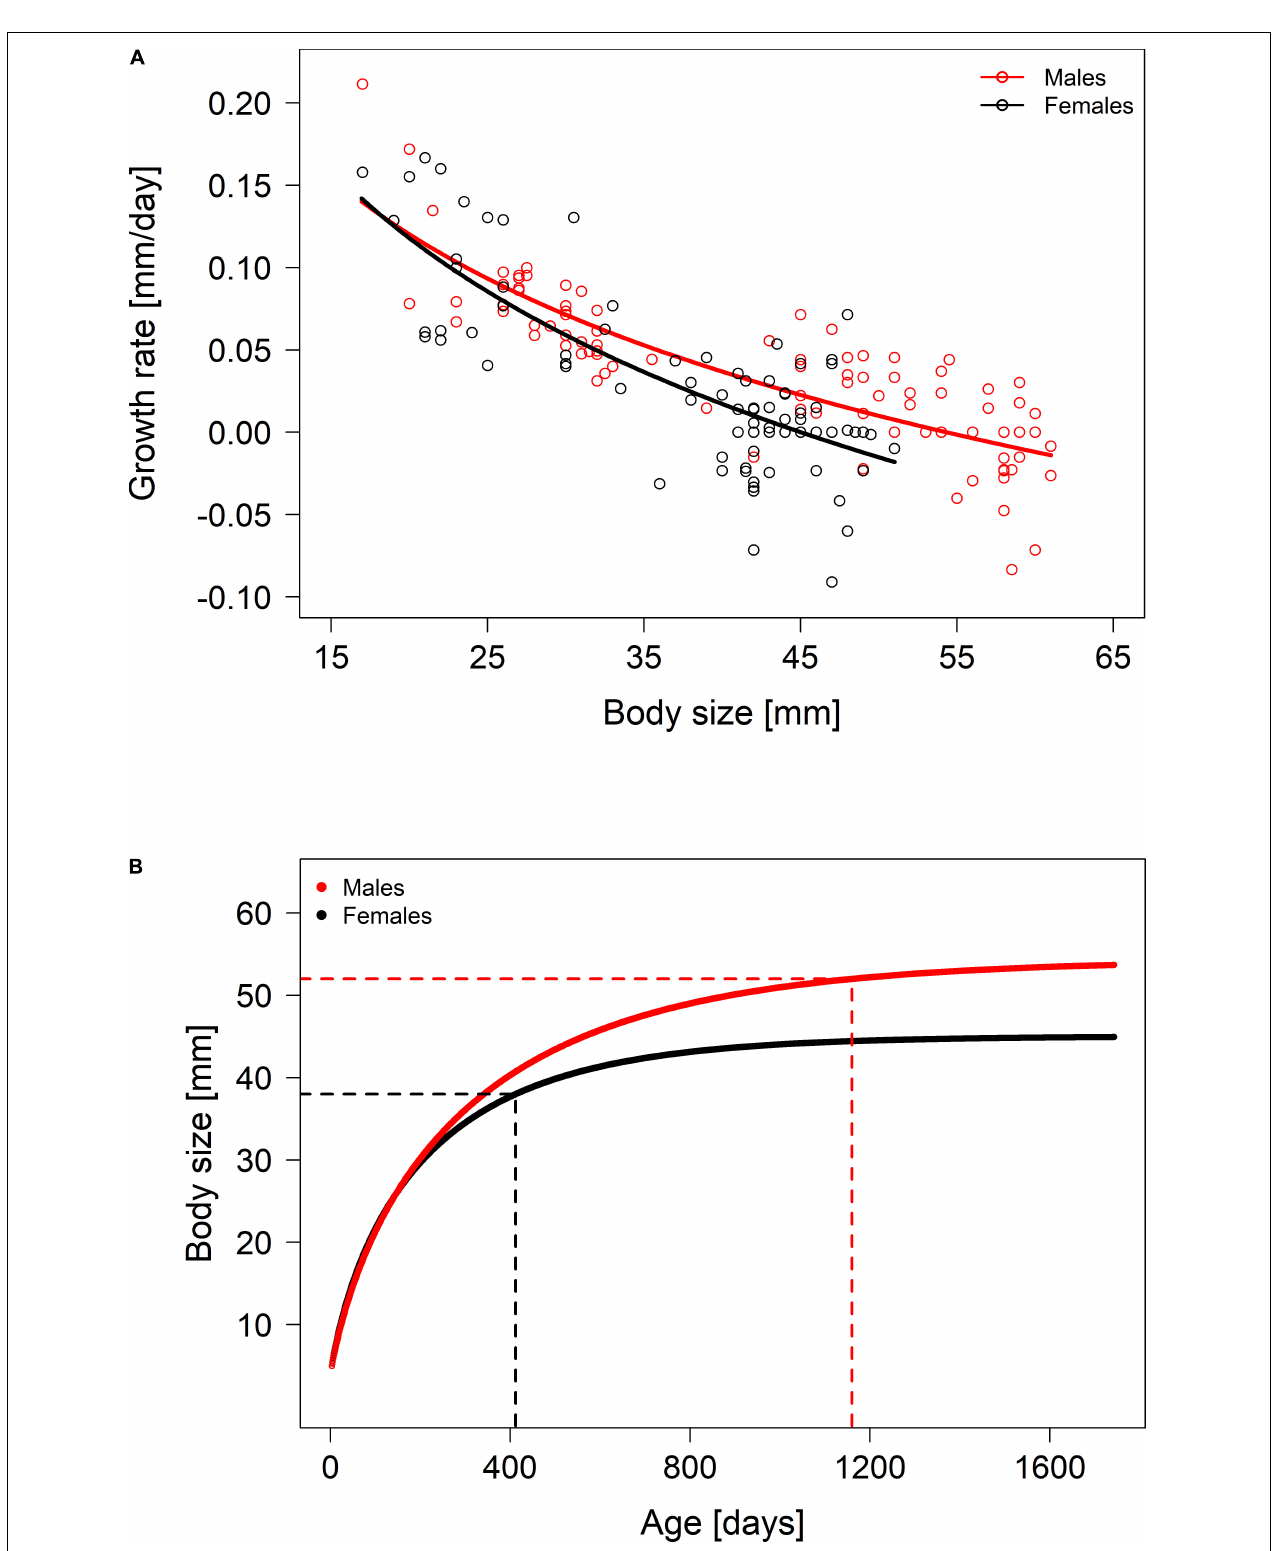
FIGURE 3 | (A) Growth rate in relation to initial body size (SL) of males (red) and females (black). Lines represent the model predicted means. Points represent original data; negative values arise due to measuring errors within and between observers. (B) Size-dependent mean predicted ages of males and females. Dashed lines mark the earliest point in time at which individuals became